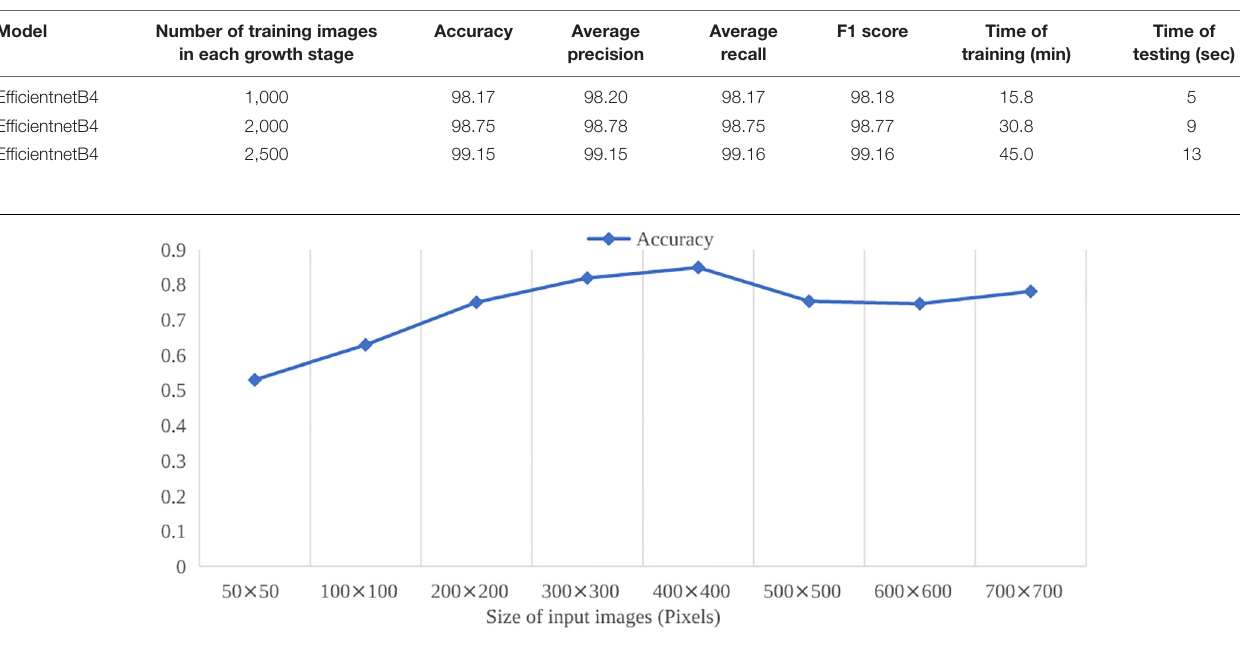
TABLE 9 | Evaluation performance on test sets for EfficientnetB4 with different numbers of training images in each growth stage.